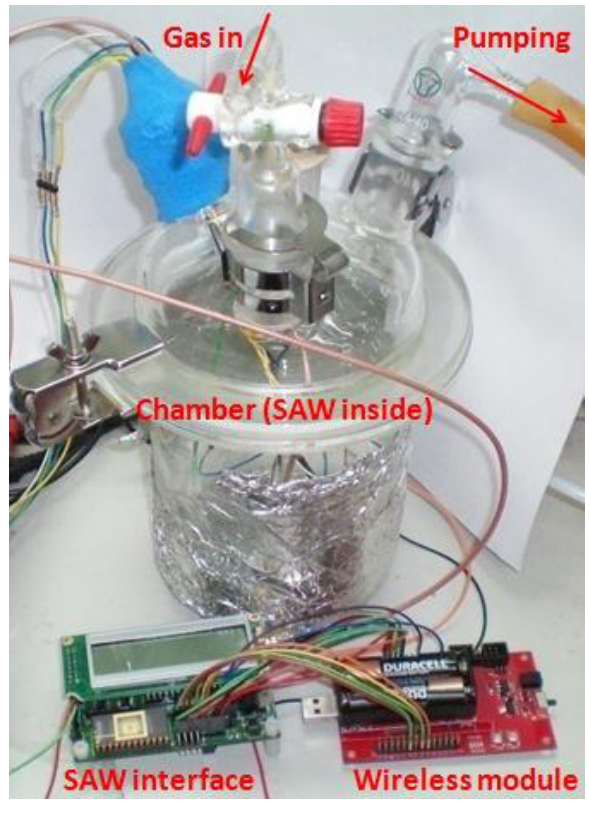
Figure 10. Test setup of the sensor